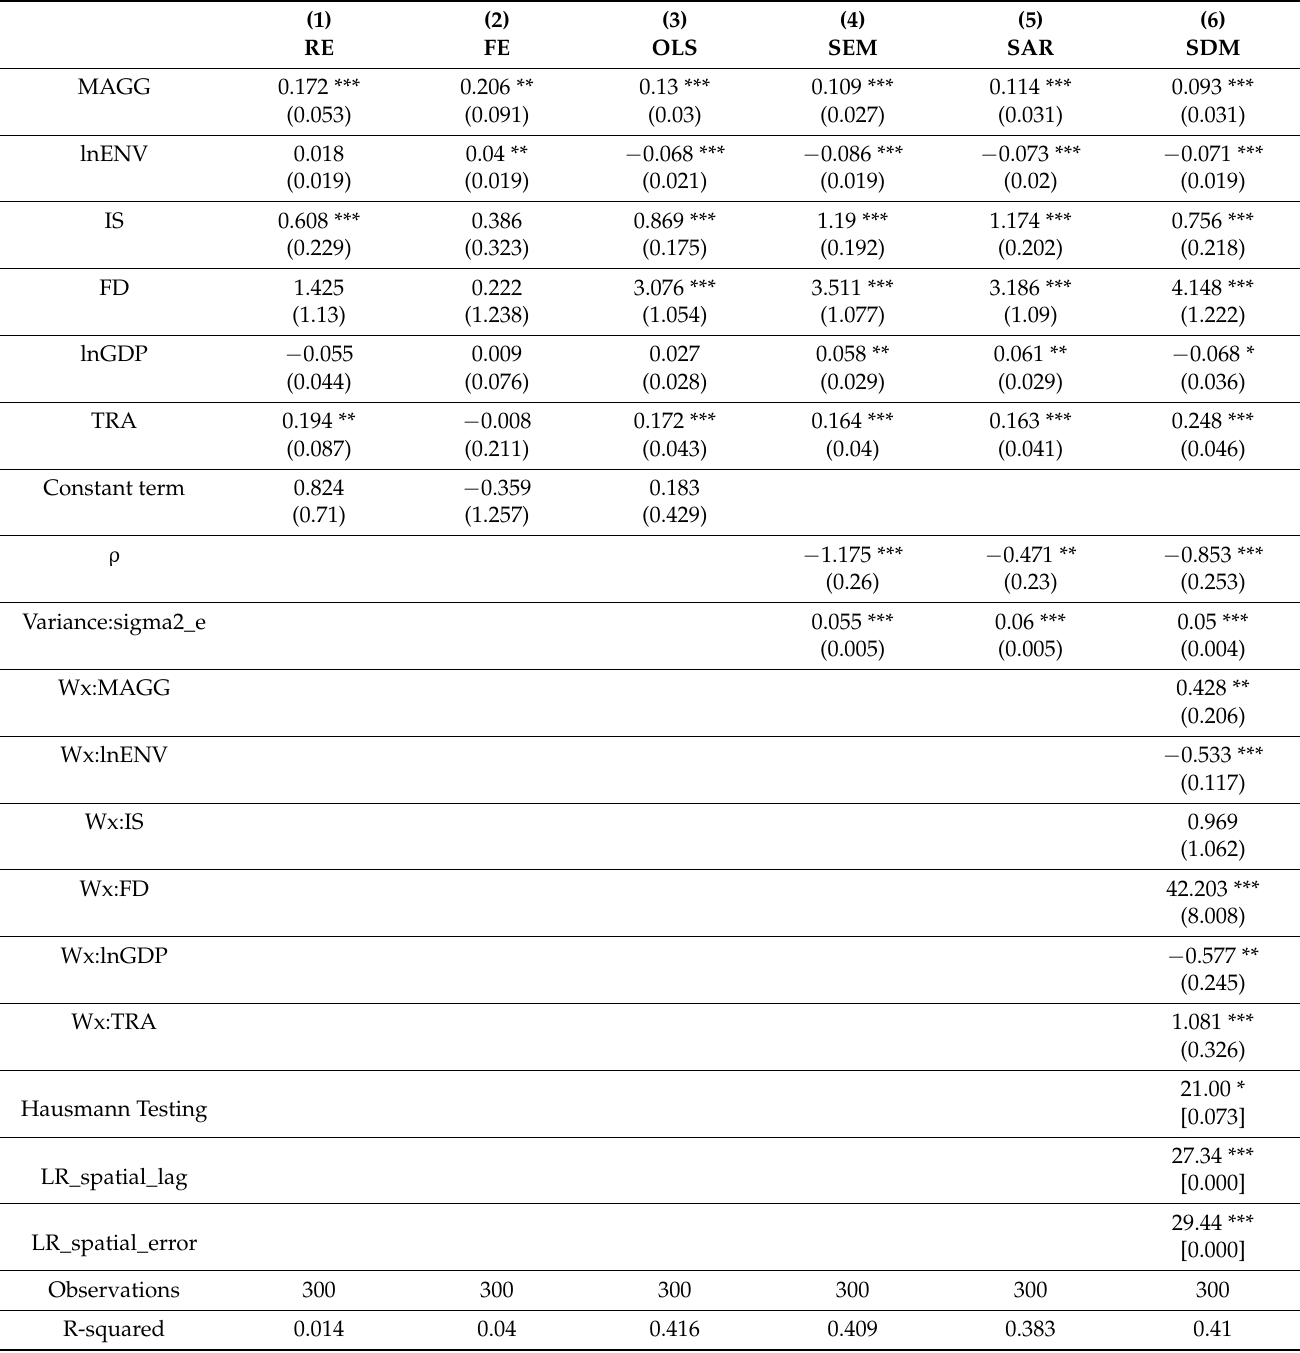
Table 7. Regression results of the impact of MAGG on GIE in